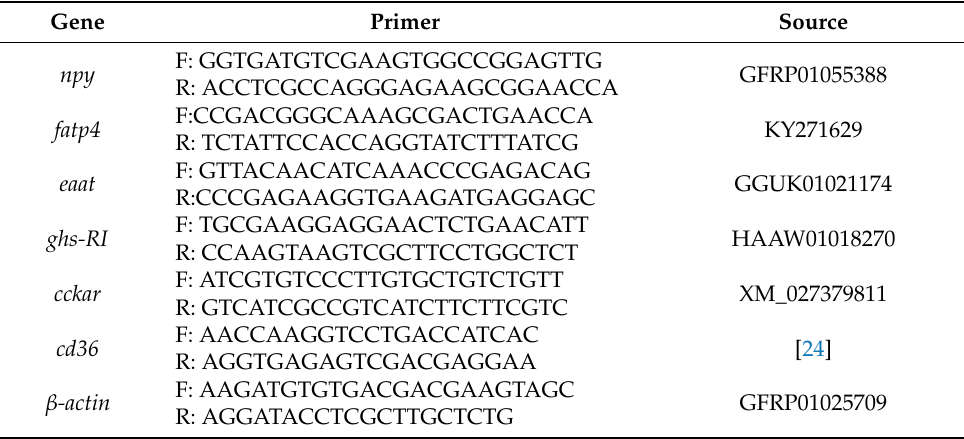
Table 3. Primer sequence used for real-time quantitative PCR